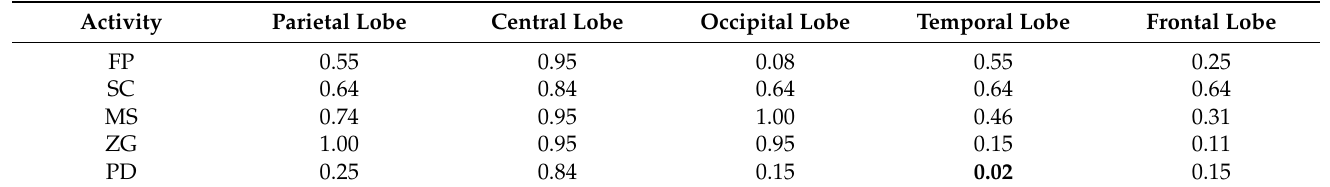
Table 8. Wilcoxon paired test: p -value results of alpha band absolute power between the control test opened eyes (CE) and each of the games (Finger Painting (FP), Sorting Cubes (SC), More Switches (MS), Zero Gravity Switches (ZG), and Punch the Dummy (PD)).